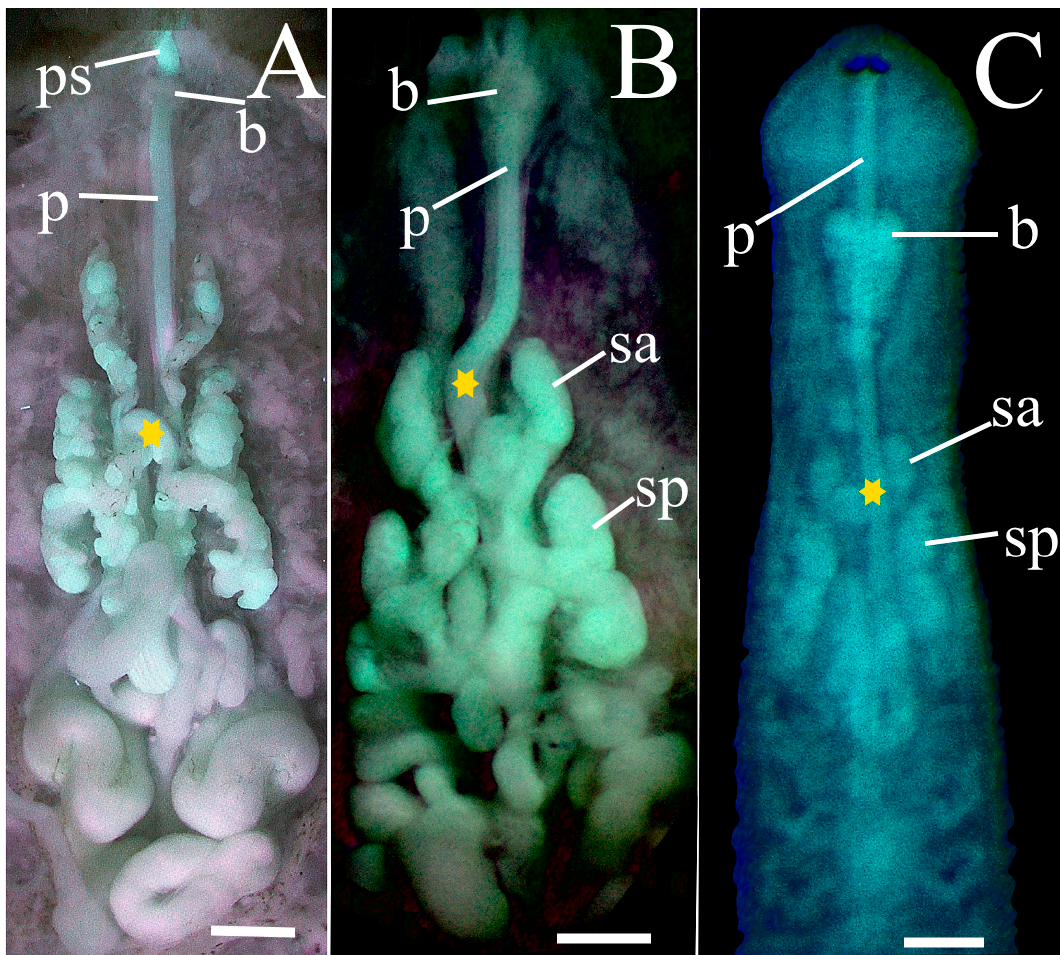
Figure 6. Taxonomic features of the proboscis complex of P. parasitica during growth and development. ( A ) PP-4a, 39.8 mm. ( B ) PP-2, 22.0 mm. ( C ) PP-4b, 6.0 mm, hatchling offspring of ( A ). Note the long tapering proboscis extends through and anterior to the brain, and the relative size, structure and positions of the salivary glands remain constant at all developmental stages. On the other hand, the proboscis at segment IX varies ( A ) from a fully coiled loop at maturity (see also Figure 7, pad), ( B ) to an asymmetrical deflection at sub-adult (see also Figure 8, pad), ( C ) to straight in the recent hatchling. Abbreviations: b, brain; p, proboscis; ps, proboscis sheath (portion anterior to brain); sa, anterior salivary gland; sp, posterior salivary gland (bilobed). Six-sided stars indicate locations at segment IX of the asymmetrical deflection of the proboscis characteristic of (post-embryonic) P. parasitica from the outer banks . Scale bars: ( A , B ) 1.0 mm; ( C ) 0.25 mm.